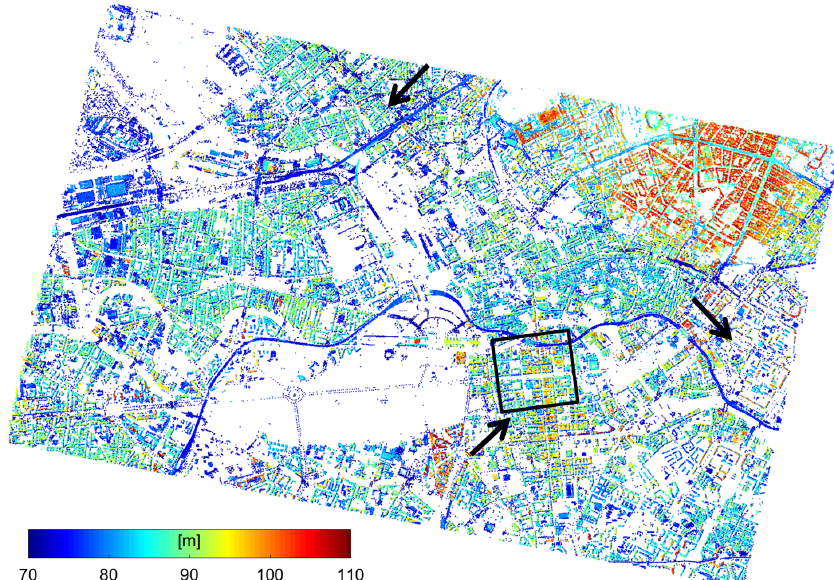
Figure 8. Geocoded PSI point cloud of Berlin, reconstructed from Beam42, in UTM coordinates. The ellipsoidal height is colorcoded. The x - and y -axis correspond to the UTM East and North, respectively. The test sites used for vertical and horizontal accuracy analysis are marked with black rectangle and black arrows,